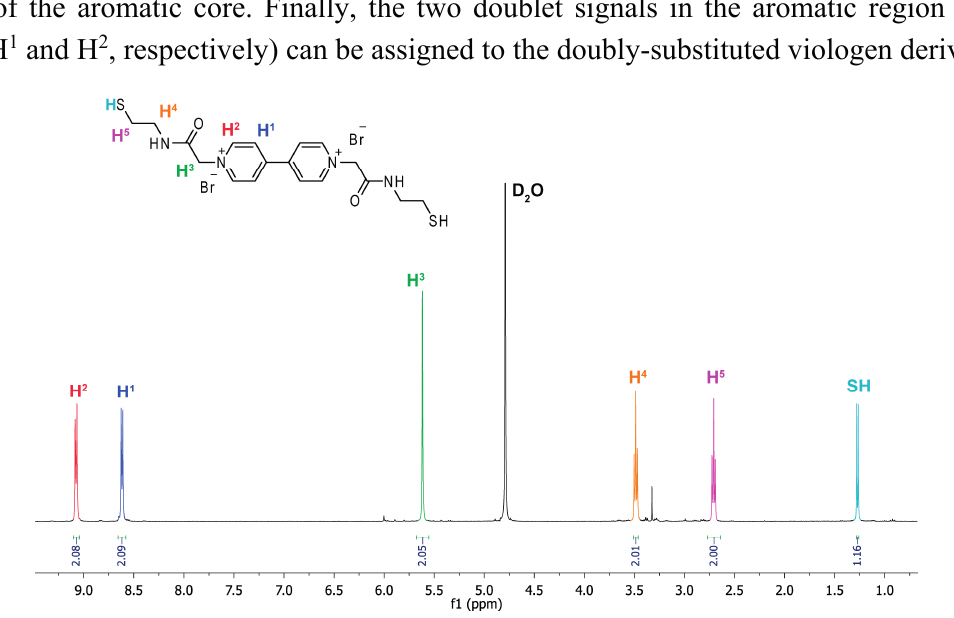
Figure 2. Part of the 500-MHz 1 H NMR spectrum of thiol-functionalized viologen Component 7 in D 2